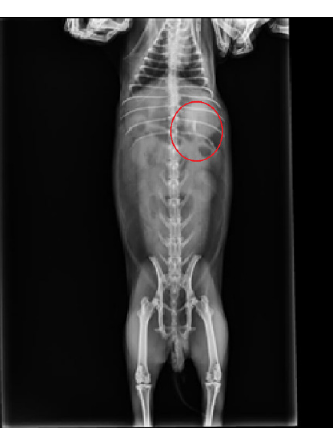
Figure 8(E) - X-ray image of Rabbit at 4h.